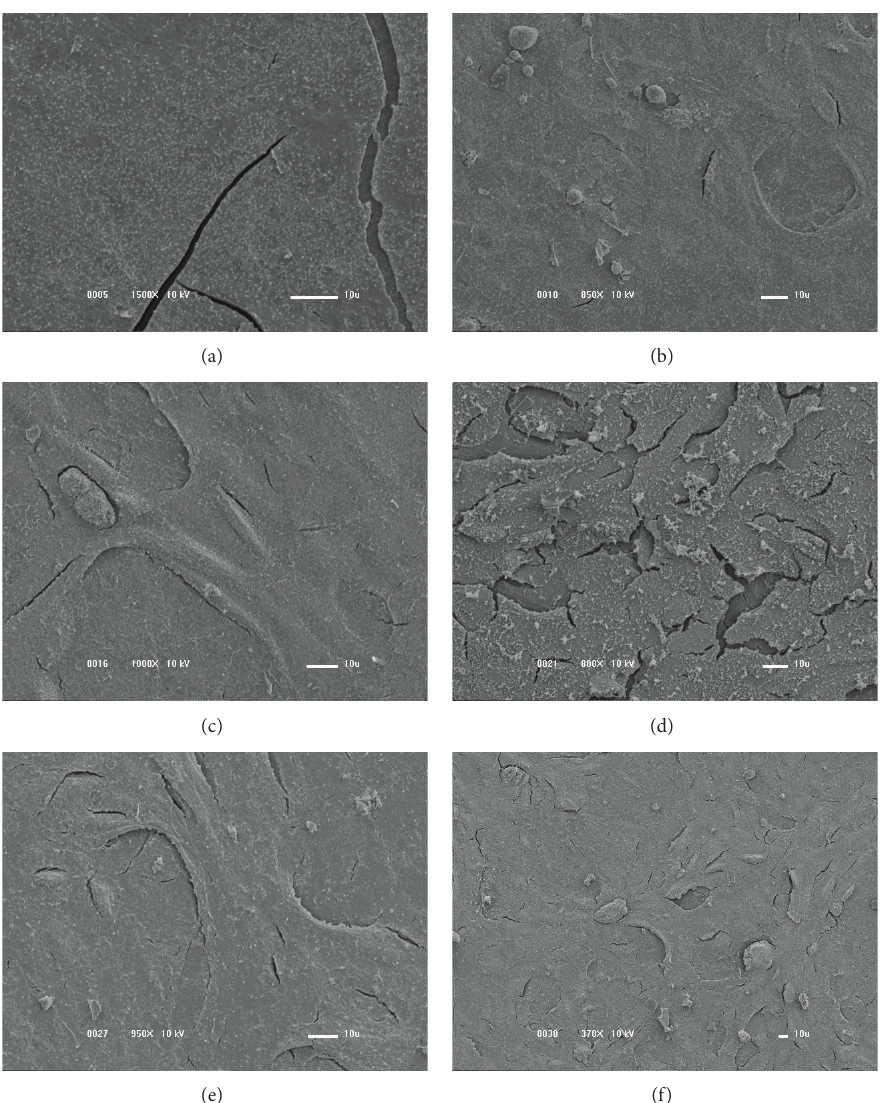
Figure 10: SEM surface images of PVC samples after 144 hours of cellular cultivation. (a) Nontreated PVC plate. Sample covered with films = 5.3 %, (c) P = 28.9 %, (d) P = 44.7 %, (e) P = 55.3 %, and (f) P = 65.8 prepared with (b) P Ar Ar Ar Ar Ar